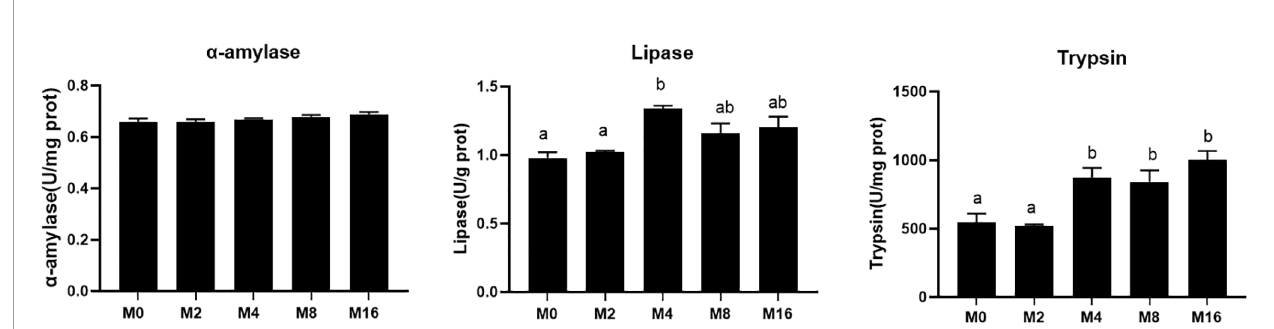
FIGURE 4 | Effects of dietary MOS on digestive enzymes in hepatopancreas of Litopenaeus vannamei . a,b Value bars not sharing the same superscript letter are signi fi cantly different as evaluated by Tukey ’ s test ( p < 0.05). MOS, mannan